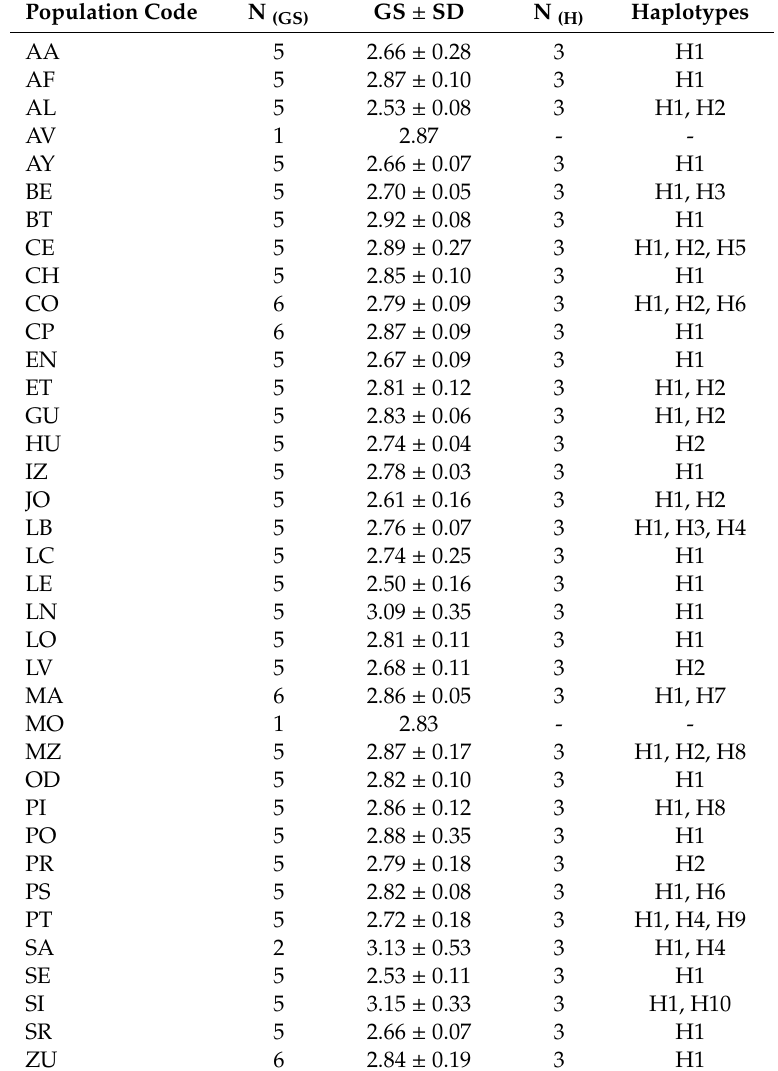
Table 1. Genome size (GS) values and haplotypes of 37 and 35 bearberry populations respectively analyzed for those variables. The number of individuals studied for genome size assessment [N (GS) ] and for haplotype analysis [N (H) ] are also